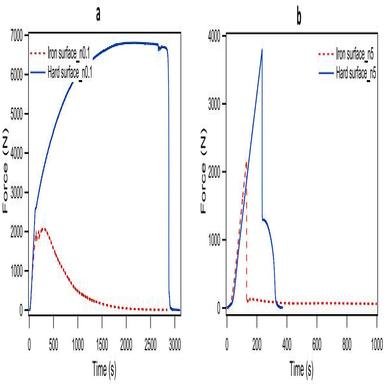
The force-time graphs acquired during the bending tests for a) n0.1 and b) n5 gradient values as loaded from the iron and hard surfaces.